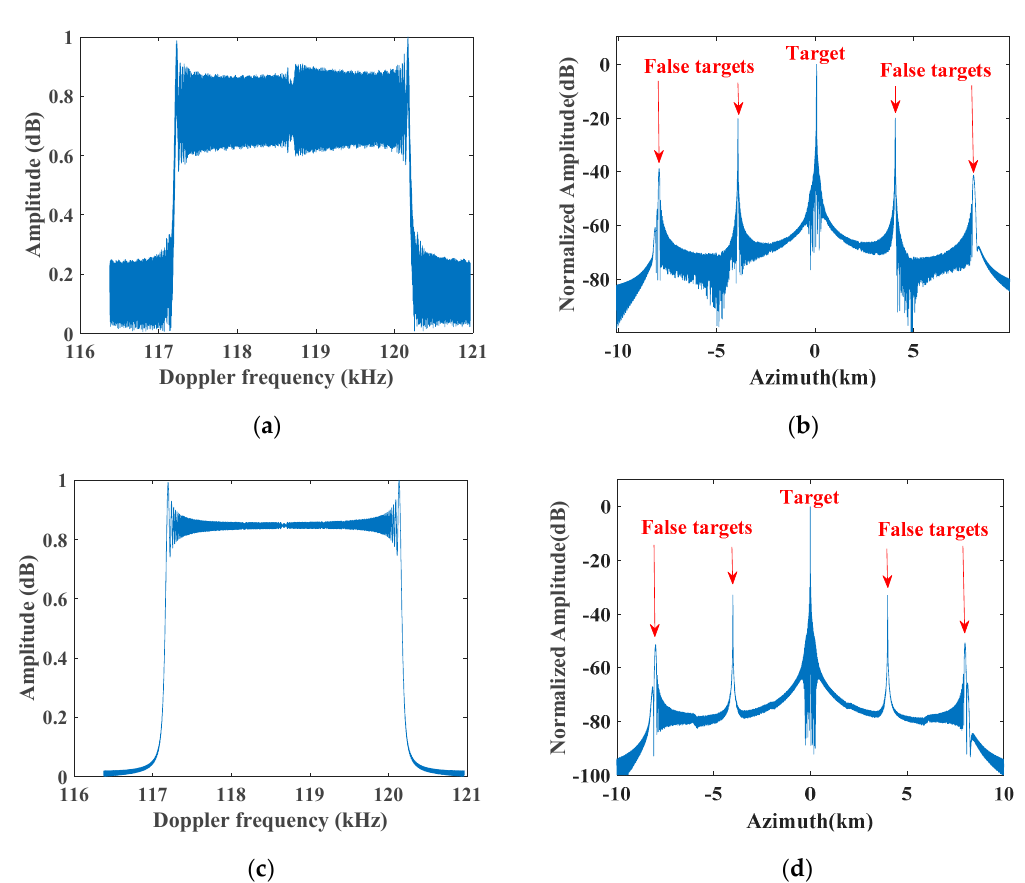
Figure 5. Azimuth multichannel reconstruction results in the monostatic DPCMAB SAR system. ( a ) Azimuth spectrum without azimuth multichannel reconstruction; ( b ) azimuth compression result without azimuth multichannel reconstruction; ( c ) azimuth spectrum after conventional azi- muth multichannel reconstruction; ( d ) azimuth compression result after conventional azimuth multichannel reconstruction.